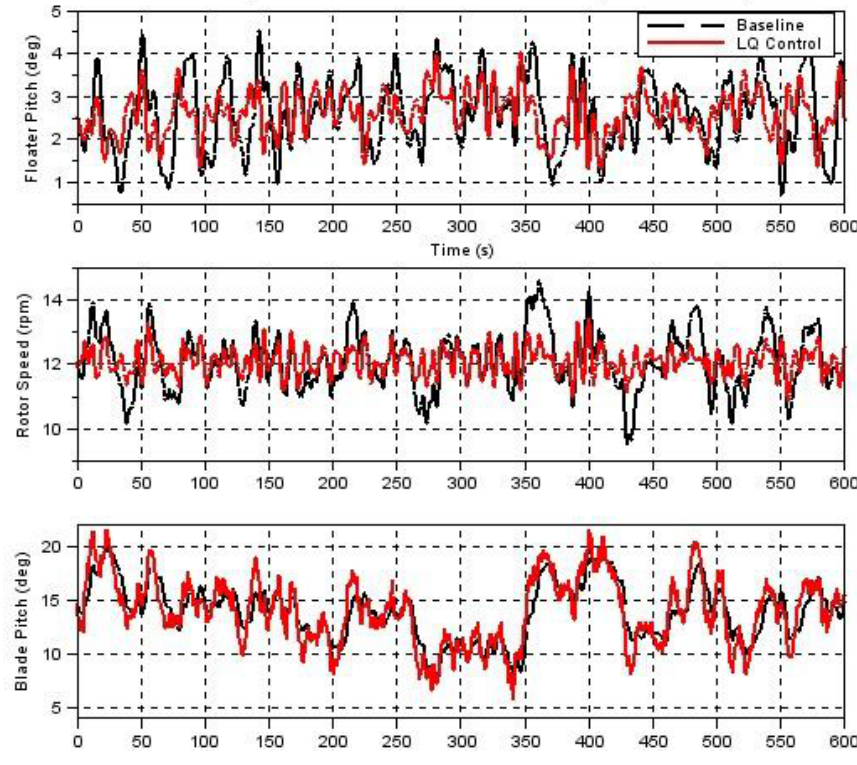
Figure 4. LQ control of a spar FOWT—moderate sea state.